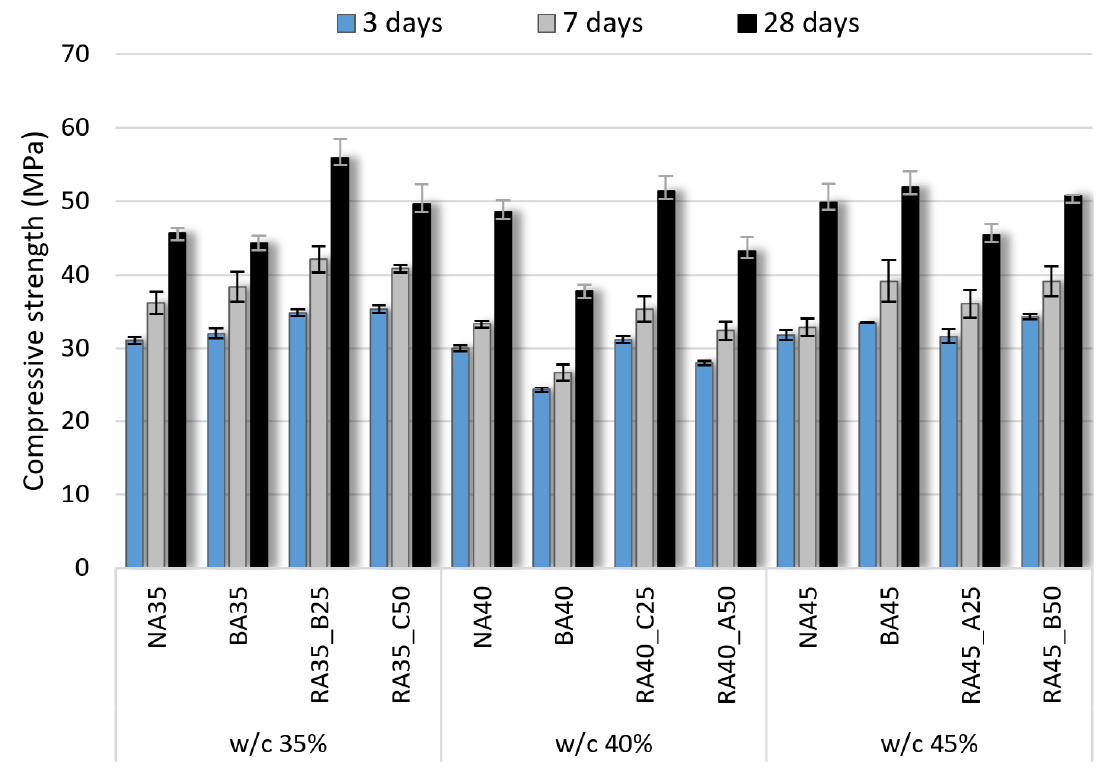
Figure 6. Compressive strength of concrete specimens according to water–cement (w/c) ratio.